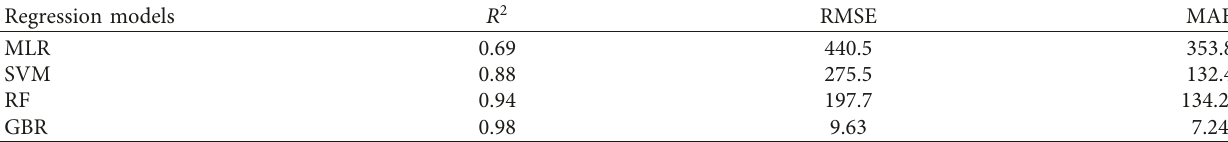
Table 1: Validation results of downscaled precipitation